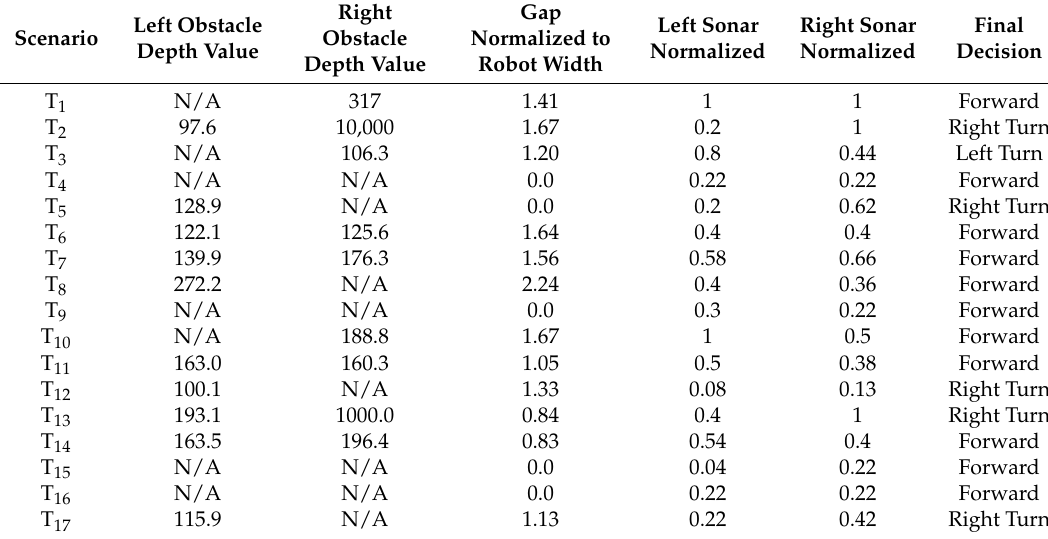
Figure 17. The seventeen scenarios (T 1 –T 17 ) where decisions of the robot were recorded. Table 4. Sensors Inputs and Decision for Scenarios T 1 –T 17.